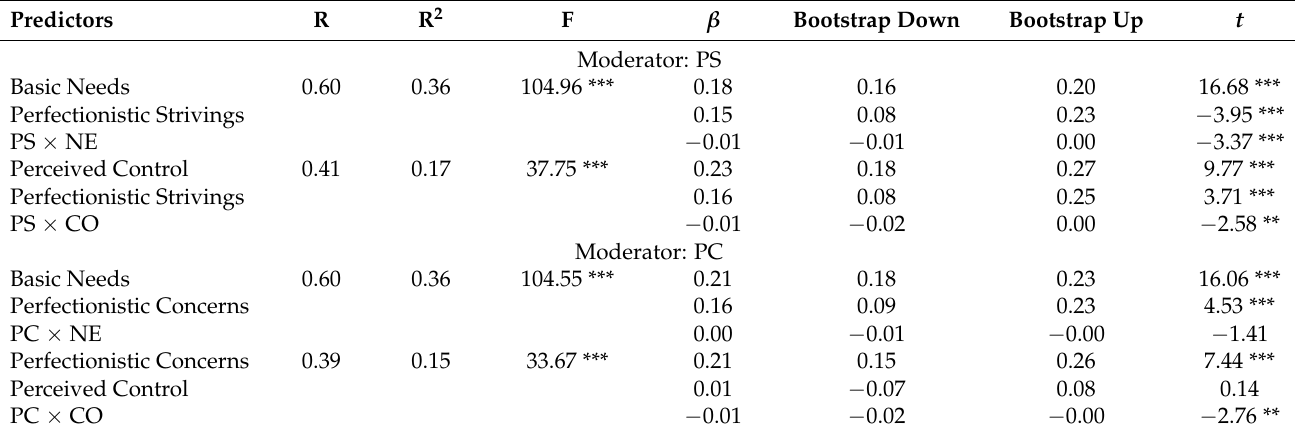
Table 2. Results of moderating analysis of life satisfaction.